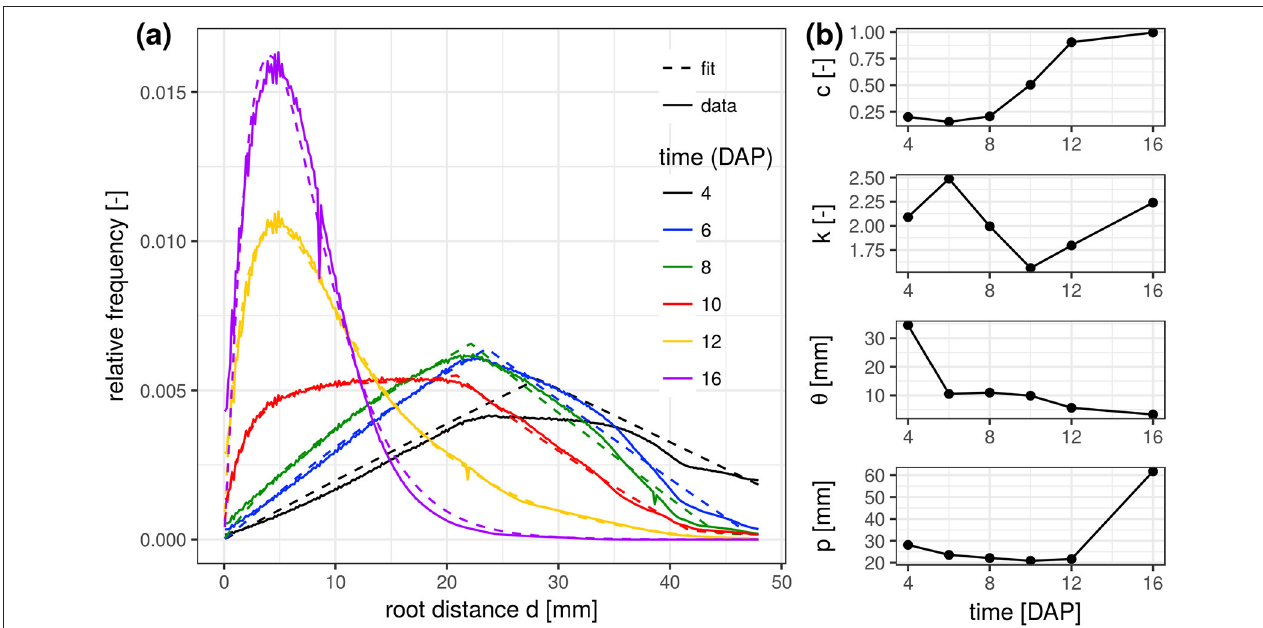
FIGURE 3 | (a) Root distance histograms for all time steps in the FS treatment including the fitted mixed triangular-gamma models (Equation 4). (b) Time series of the four parameters of the mixed triangular-gamma model: c , weighting factor; k , shape parameter; θ , scaling parameter; p , tap root-wall distance.